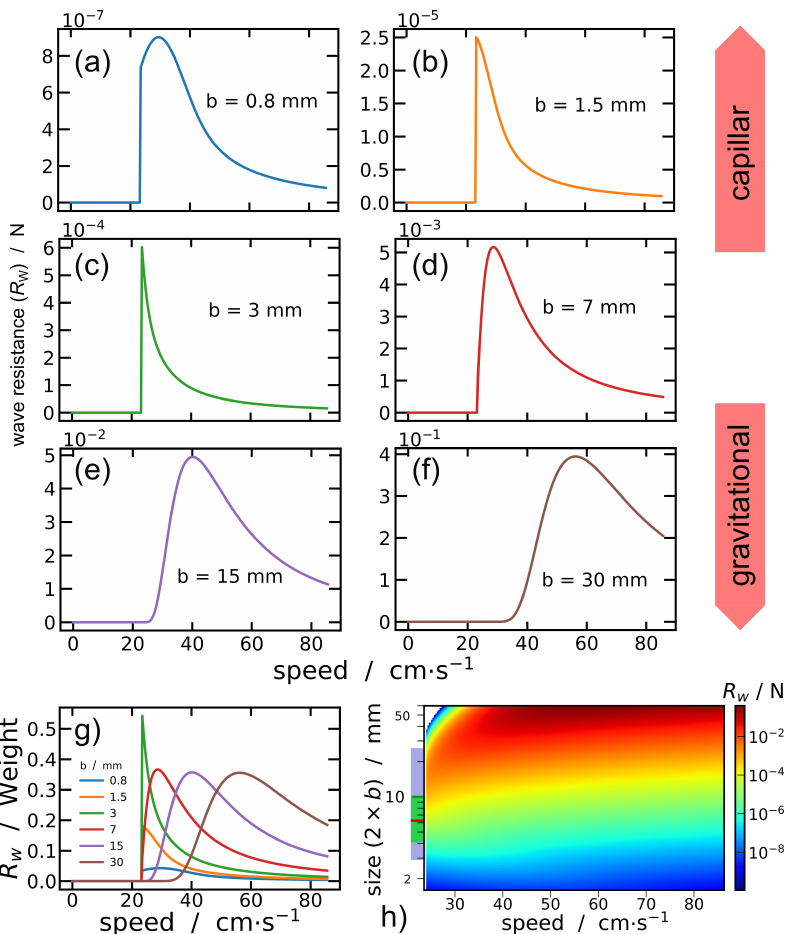
Figure 3. Wave resistance R w as a function of speed for different sizes of whirligig beetles ( a – f ). Note that there roughly a difference of a factor of ten for R w between each consecutive size. From figure ( a – f ), waves change from a capillar to a gravitational regime. ( g ) R w divided by the weight of the insect. ( h ) R w as a function of the insect’s size and speed (log scale for the size and R w ). The range of sizes of whirligig beetles is highlighted in light blue on the axis, the green rectangle indicates the standard deviation of the size distribution around the mean, and the red line indicates the